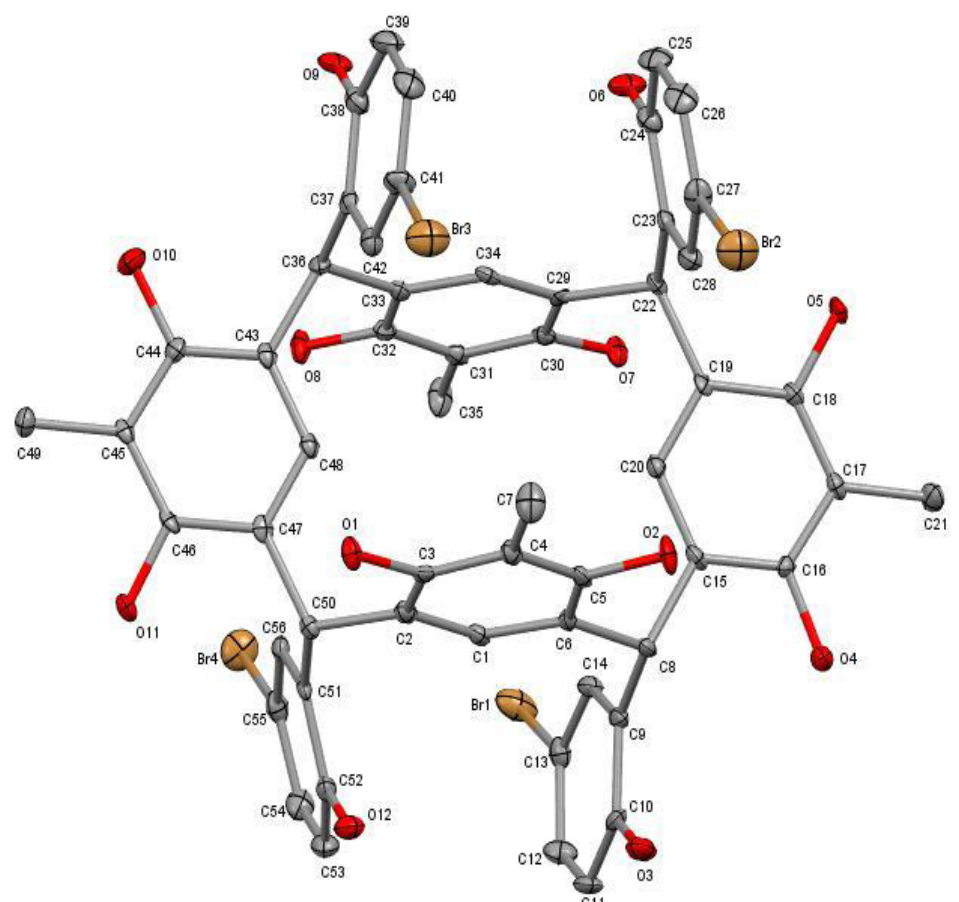
Figure 2. The molecular structure of C-5-bromo-2-hydroxyphenylcalix[4]-2-methyl- resorcinarene drawn at 50% probability ellipsoid. The hydrogen atoms and solvent molecules are not shown for